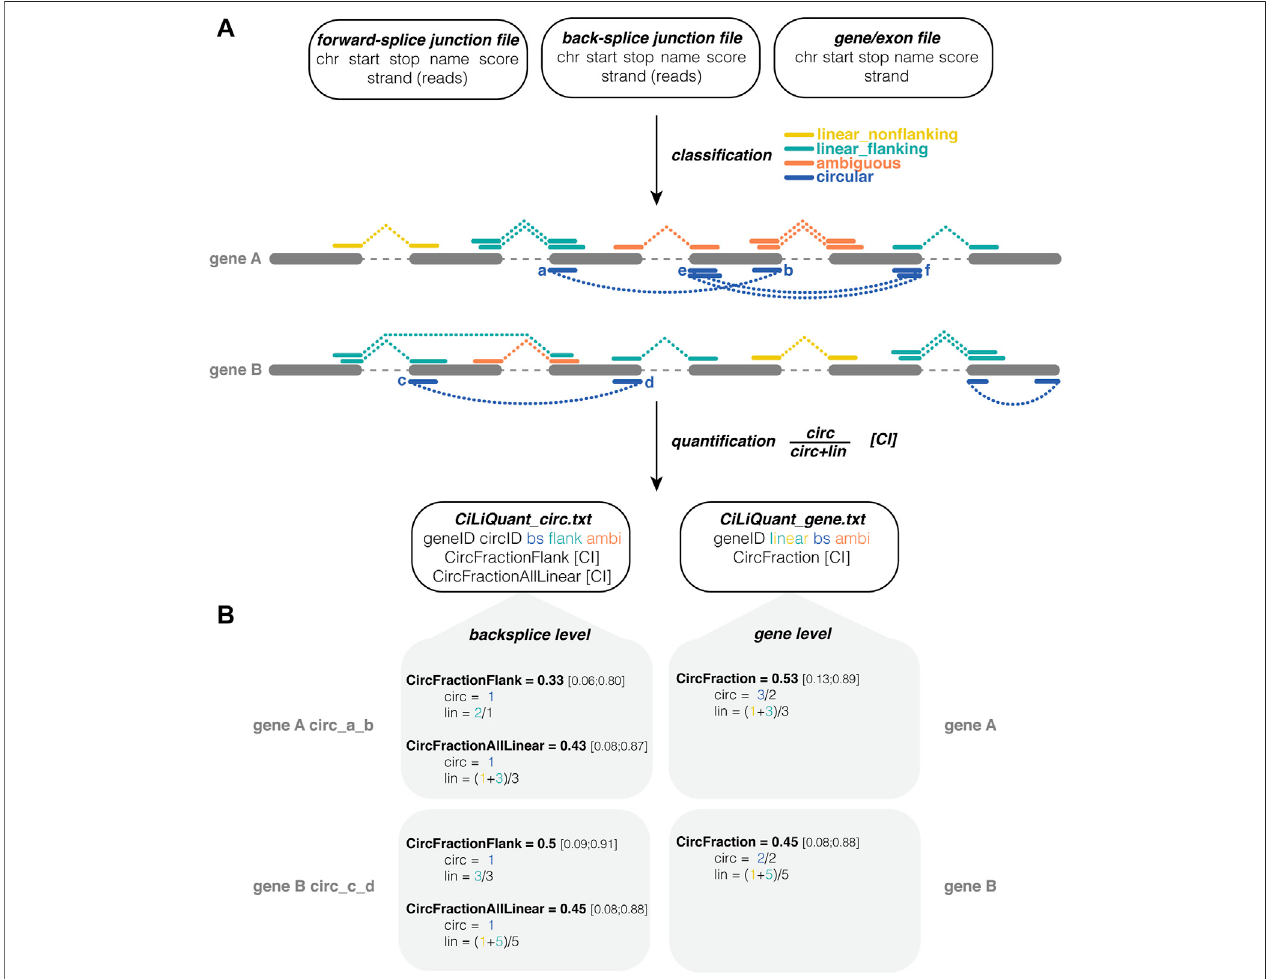
FIGURE 1 | CiLiQuant classi fi es splice junctions based on their linear or circular origin and determines circRNA fractions. (A) Input, processing and output of the pipeline. Three input fi les required (number of junction reads may be in separate column or in score column), junctions are divided into four types based on overlap with detected circRNAs, quanti fi cation both at back-splice and gene level; (B) Examples of circRNA fraction calculations. CircFractionFlank only considers linear junctions directlynexttotheback-spliceofinterest(linear_ fl anking).CircFractionAllLinearandCircFractionconsideralllinear(linear_ fl ankingandlinear_non fl anking)junctions in the gene. In each calculation the sum of junction reads is corrected for the number of distinct junctions. Note that the counts in this example are rather low resulting in largecon fi denceintervals.TestcasewithrealsequencingdataonGitHub.ambi:ambiguous(circularorlinearorigin);bs:back-splice;chr:chromosome;CI:Agresti-Coull 95% con fi dence interval; linear_ fl anking: forward-splice that partially overlaps with a back-splice junction (starts outside and stops inside the back-splice interval or vice versa); linear_non fl anking: forward-splice that shows no overlap with a back-splice junction.